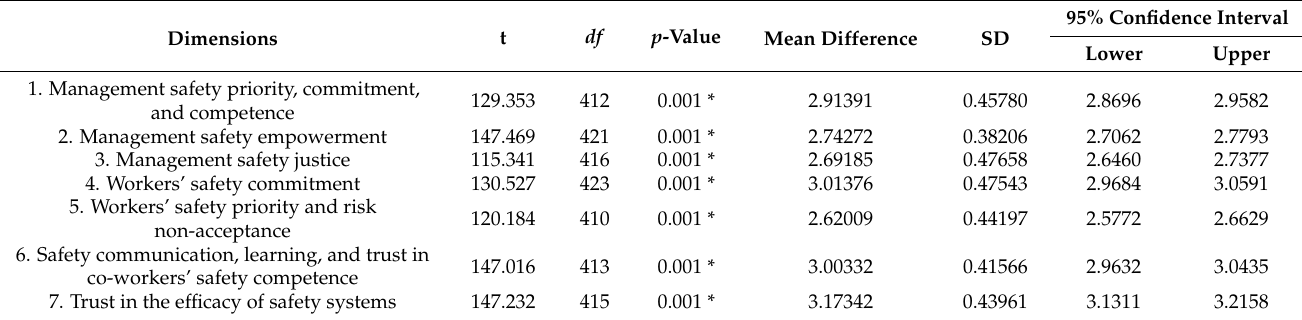
Table 3. One-sample test for the seven domains measured.